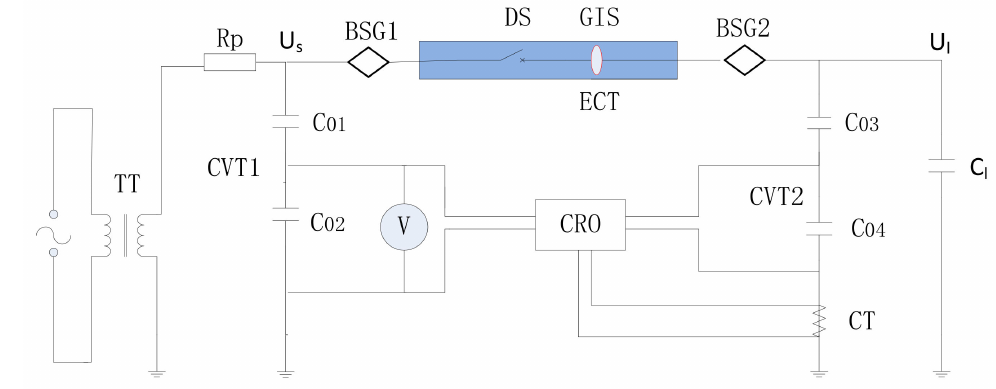
Figure 1. Test duty 3 of switching of bus-charging currents